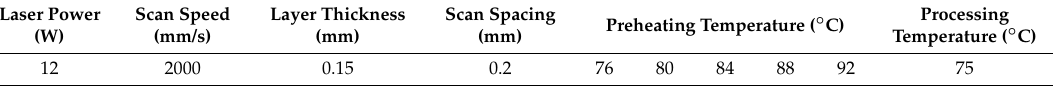
Figure 4. Sintering method: ( a ) additive direction and ( b ) placement of the sample. Table 2. Processing parameters of the WSPC powder for selective laser sintering (SLS).